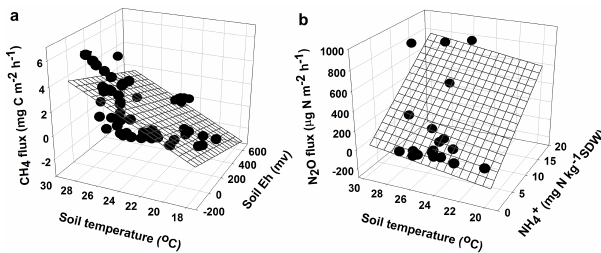
Figure 4. Relationships of (a) methane (CH 4 ) emissions to soil tem- perature and redox potential ( E h ) in the control of conventional paddy rice production system (i.e., CNN) and (b) nitrous oxide (N 2 O) emissions to soil temperature and ammonium (NH + tents in the urea application treatment of ground cover rice produc- tion system (i.e., GUN) during the rice-growing season. The mesh plots are the result of multiple linear regression analysis according to the equations presented in Table